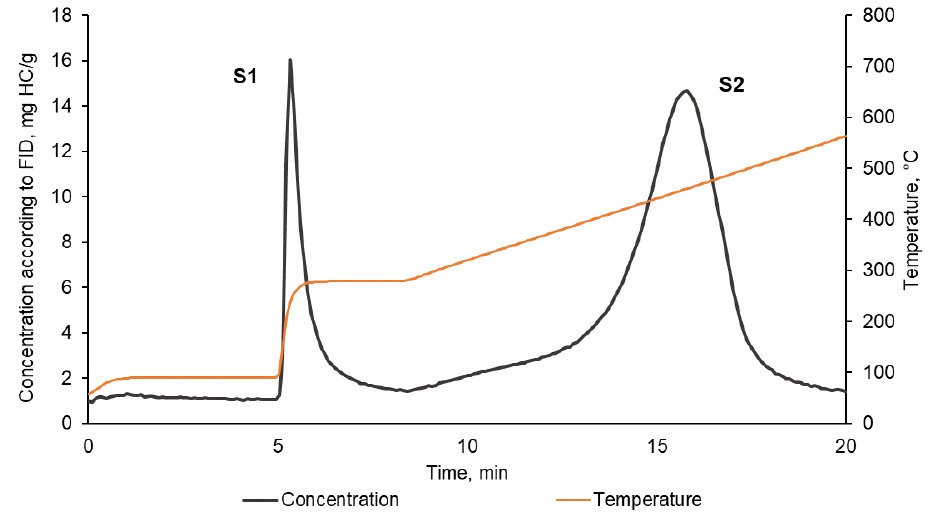
Figure 1. Example of dependencies registered during pyrolysis of a rock sample.